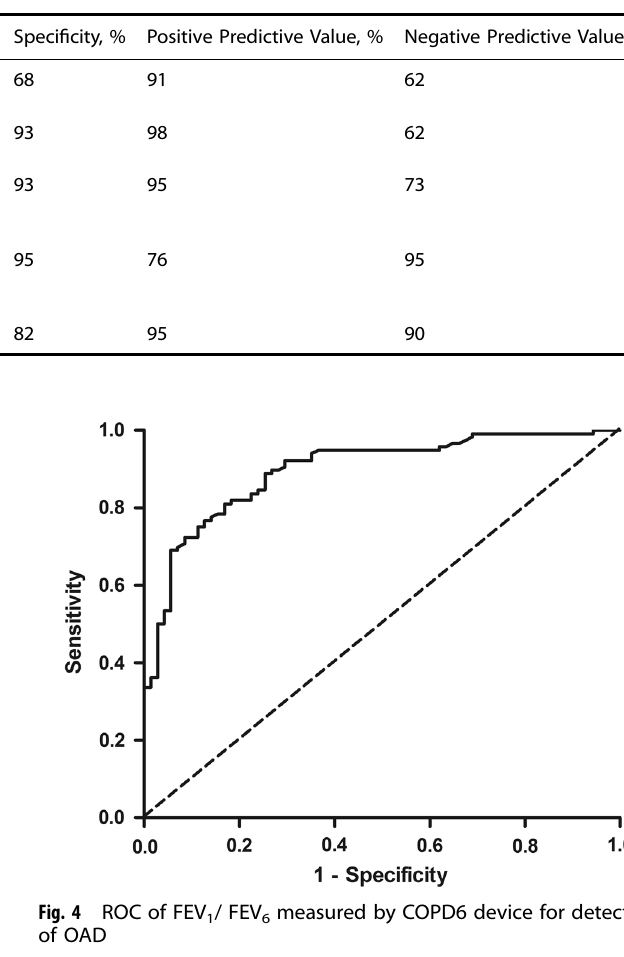
Table 3. Accuracy of peak fl ow meter with and without symptoms for detection of OAD and detection of asthma and COPD